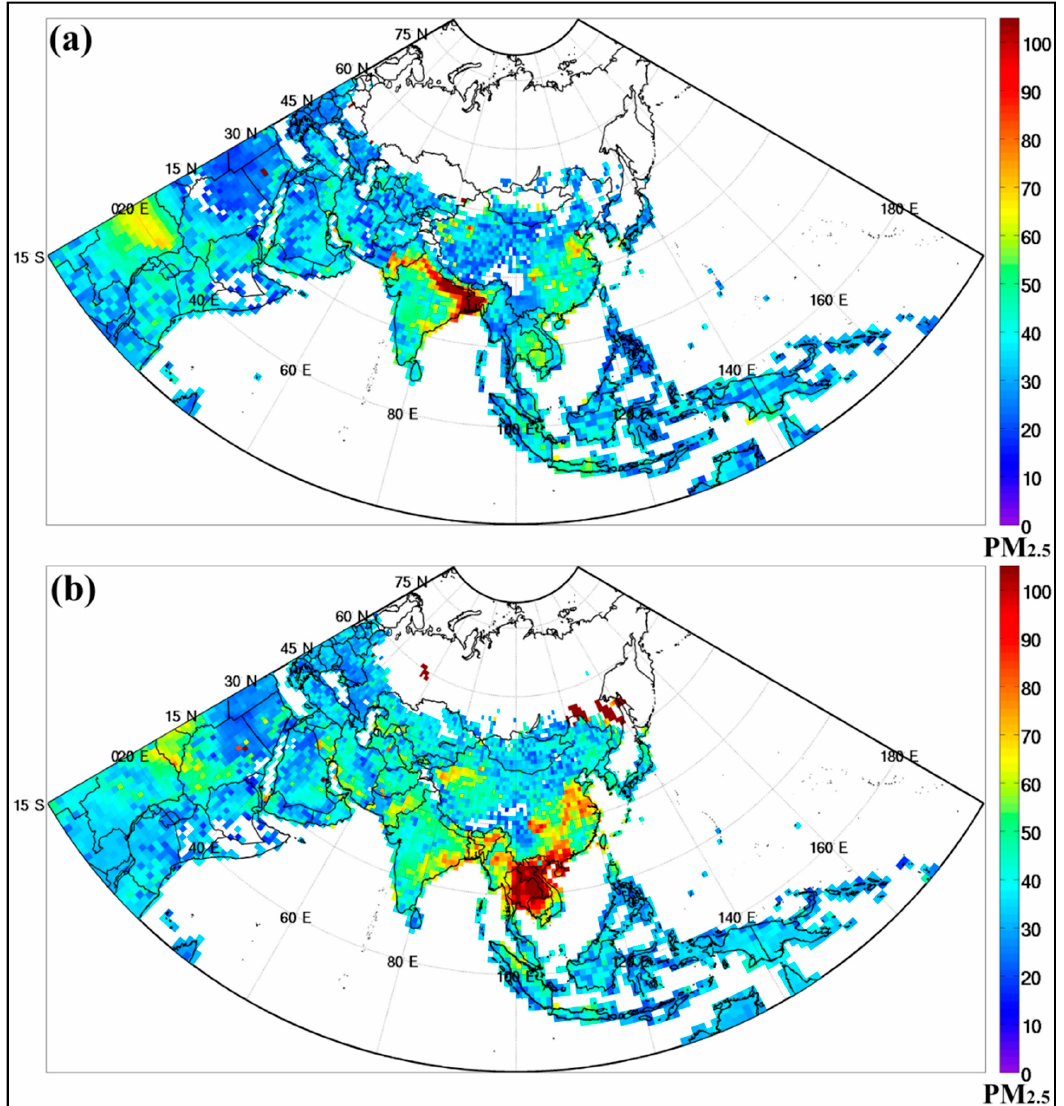
Figure 2. The transition of heavy PM 2.5 ( μ g/m 3 ) loading from ( a ) South Asia in January 2016 to ( b ) Southeast Asia in March 2016, highly potential due to human activities in different seasons. Table 2. Unadjusted generalized linear mixed-e ff ect models of under-5 and maternal mortality in Asia. Unadjusted GLMM, IRR (95% CI) b Variable Under-5